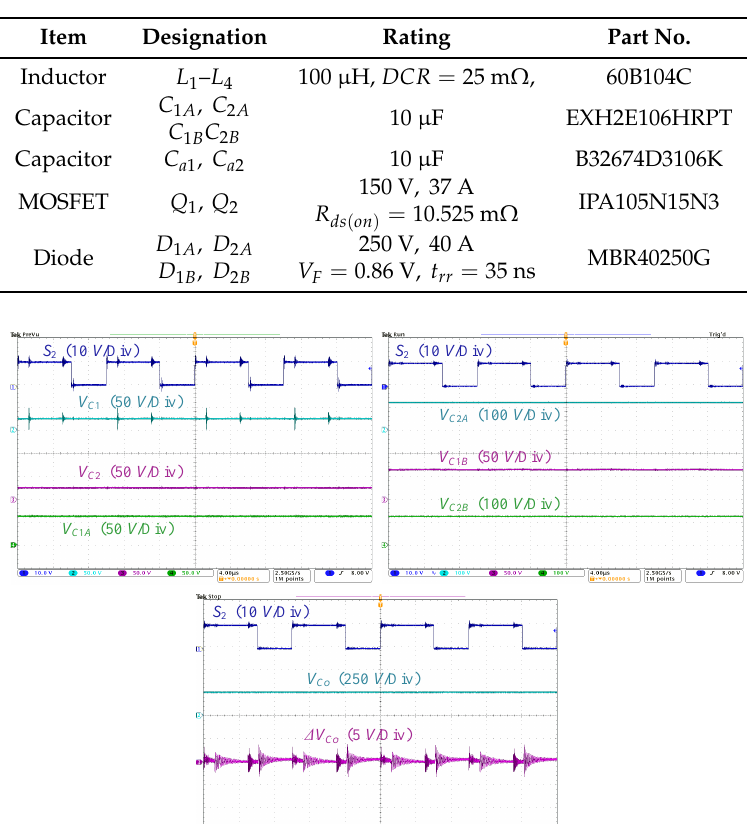
Table 6. Component Listing for the Hardware Prototype.